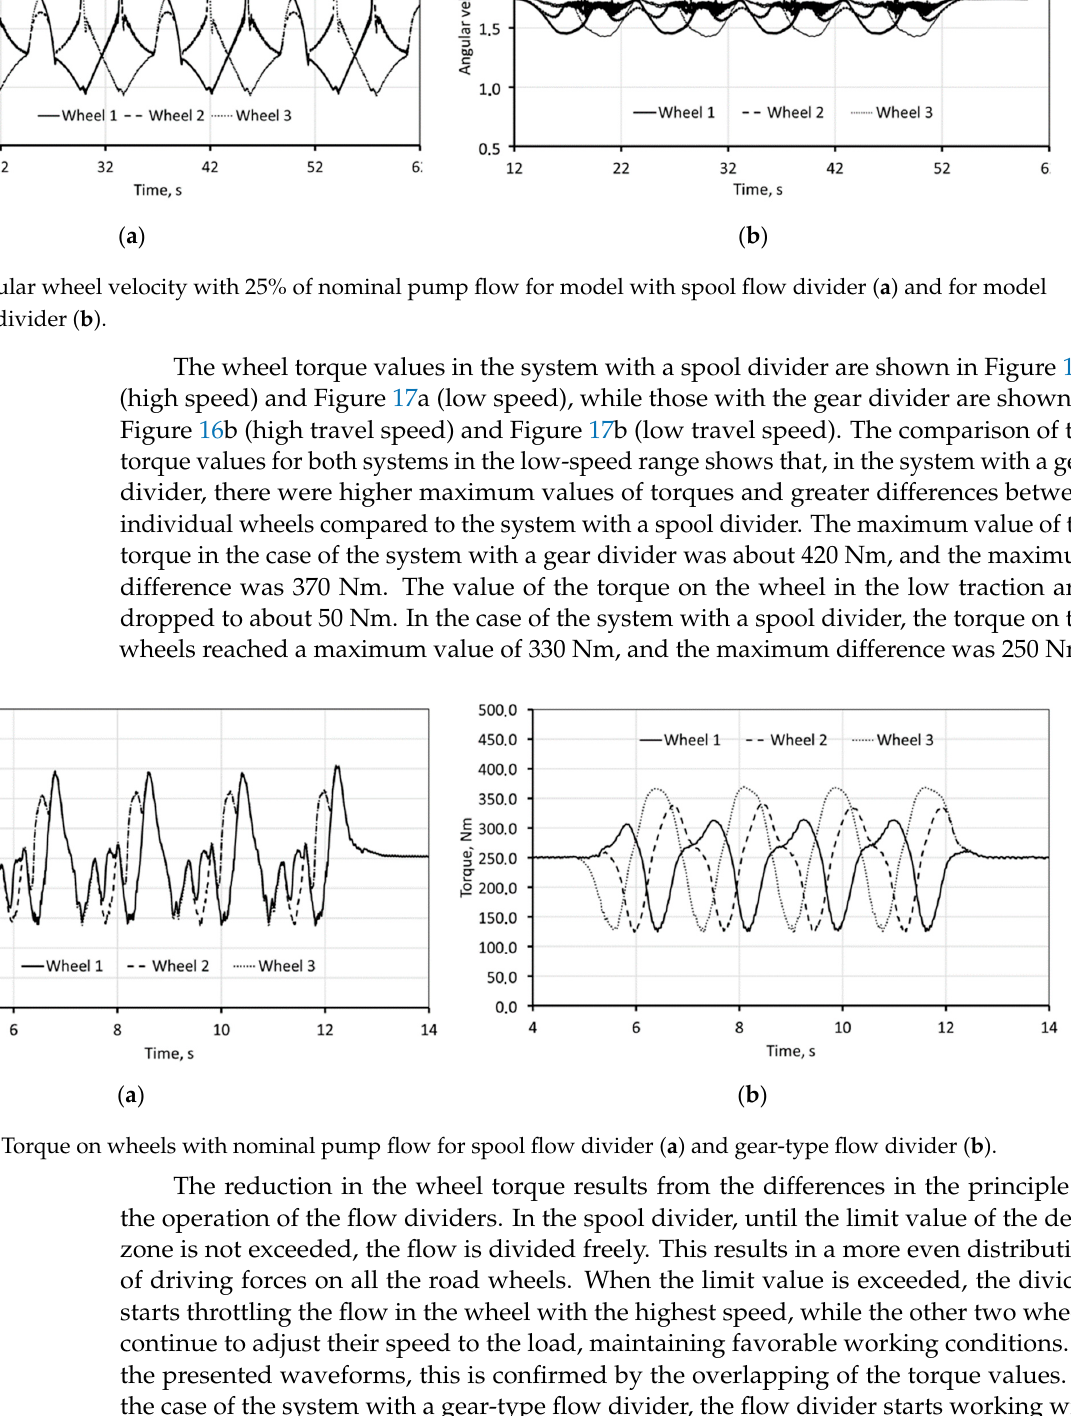
Figure 17. Torque on wheels with 25% of nominal pump flow for spool flow divider ( a ) and gear-type flow divider ( b ). The comparison of the pressure of the pump system for both divider types in the range of high driving speeds is shown in Figure 18a, and in the range of low speeds in Figure 18b. When driving at low speeds (Figure 18b), in the case of the drive system with a spool divider, the pump pressure was higher by approximately 1.0 MPa (approximately 14%) compared to the system with a gear divider, despite having the same values of re- sistance to motion. The pressure difference results from higher flow resistance through the spool divider. Additionally, pressure pulsations are visible, reaching maximum values of over 8 MPa. The pump pressure in the drive system with a gear divider remained at a relatively constant level throughout the entire run. During high-speed driving (Figure 18a), the pump pressure increased in relation to the slow speed for both systems. The maximum value of pressure in the case of the system with a spool divider was 11 MPa, while for the system with a gear divider, it was approximately 8 MPa. The pressure pul- sations also increased, which, in the case of the system with a spool divider, reached 6.5 MPa, while in the case of the system with a gear divider, it reached 2 MPa. This effect was mainly influenced by the dynamic load caused by the variable value of the traction force and the increase in the hydraulic system resistance.